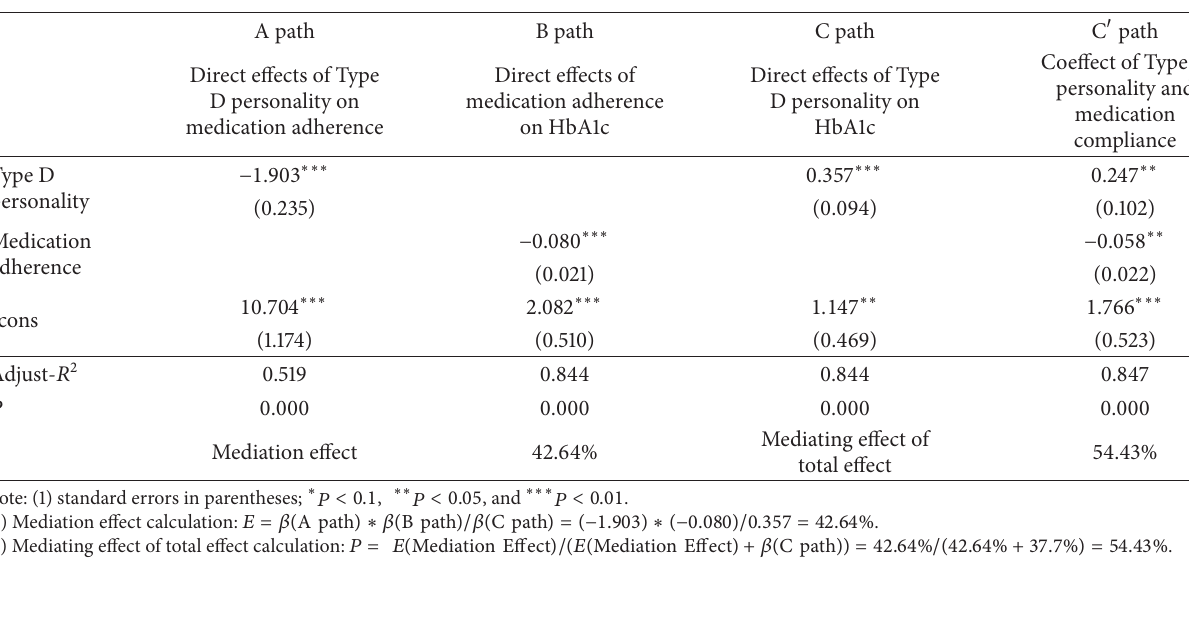
Table 5: Mediation effect between Type D personality and HbA1c.